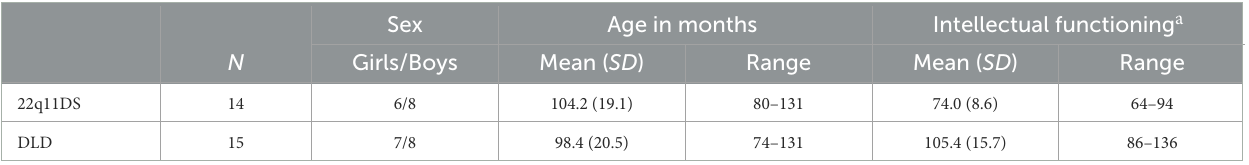
TABLE 5 Demographic characteristics of the school-aged